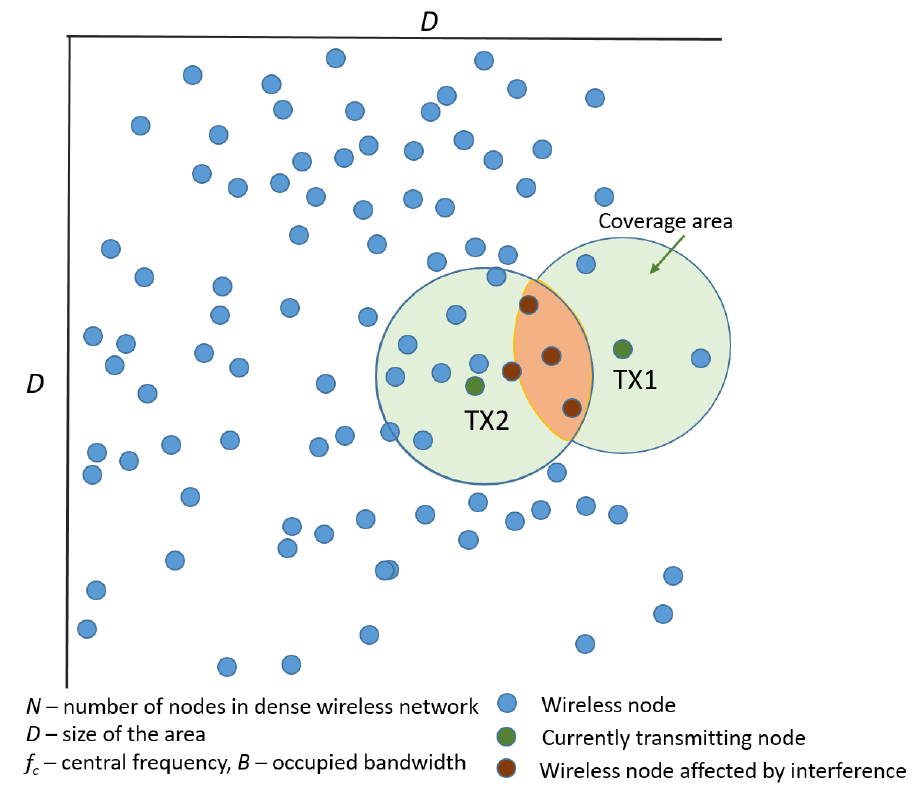
Figure 1. Considered dense wireless